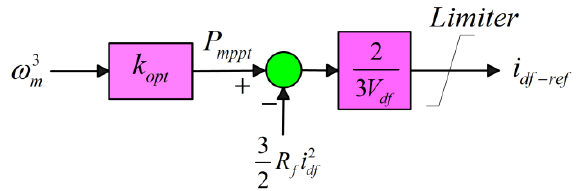
Figure 3. Calculation of i df − ref by the proposed method in [7] .